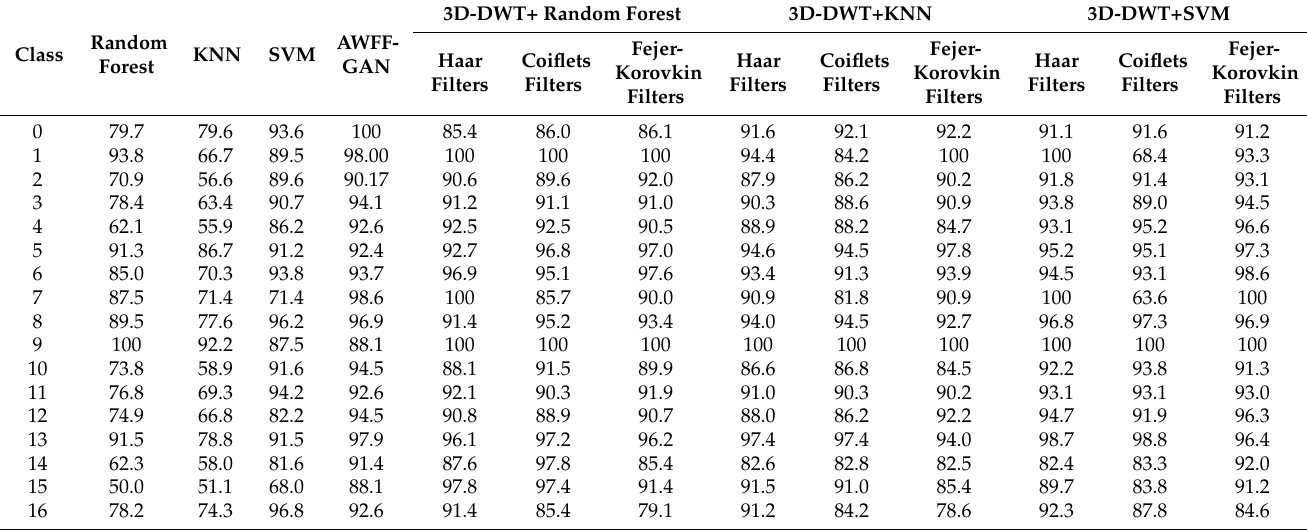
Table 2. Classification accuracy of all the computing methods in Indian Pines dataset.